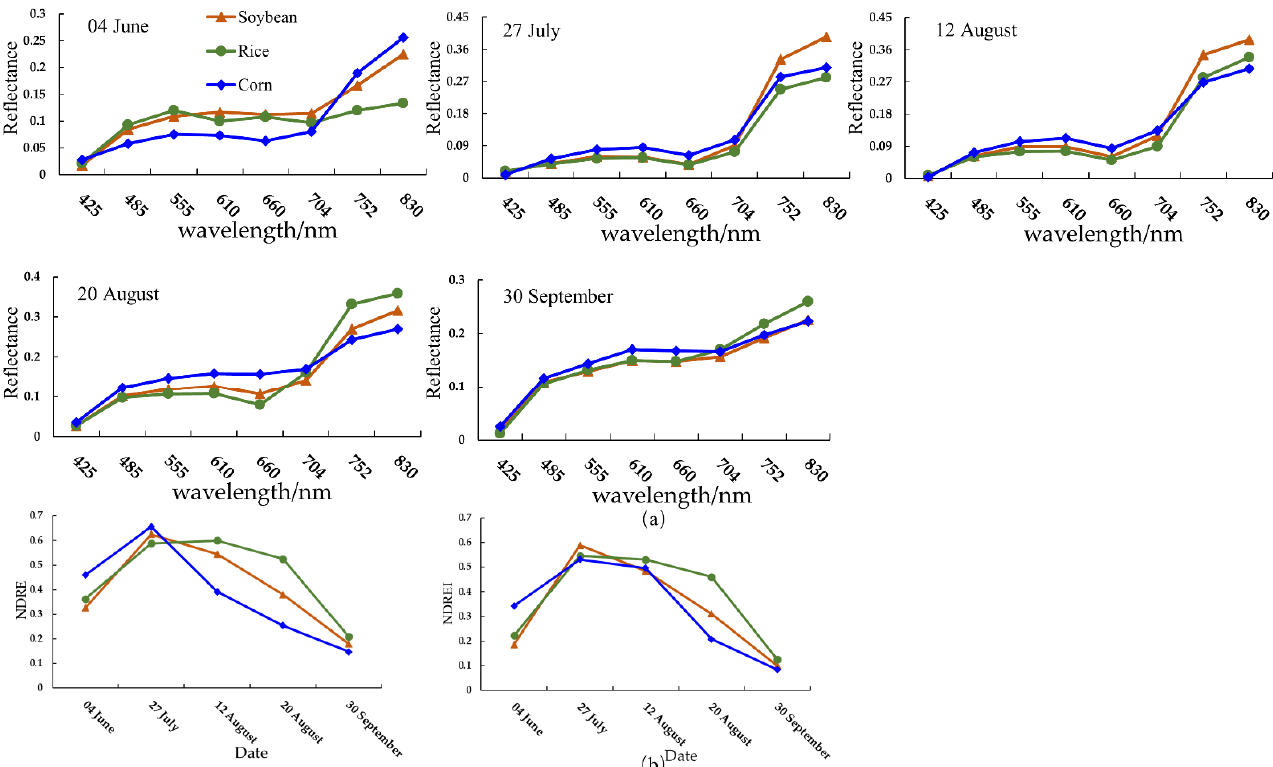
Figure 7. The spectral curves of soybean, corn, and rice in different periods ( a ) and Normalized Red-edge Difference Index (NREDI) time series and NDRE time series ( b ), the dates are 4 June 2019, 27 July 2019, 12 August 2019, 30 September 2019